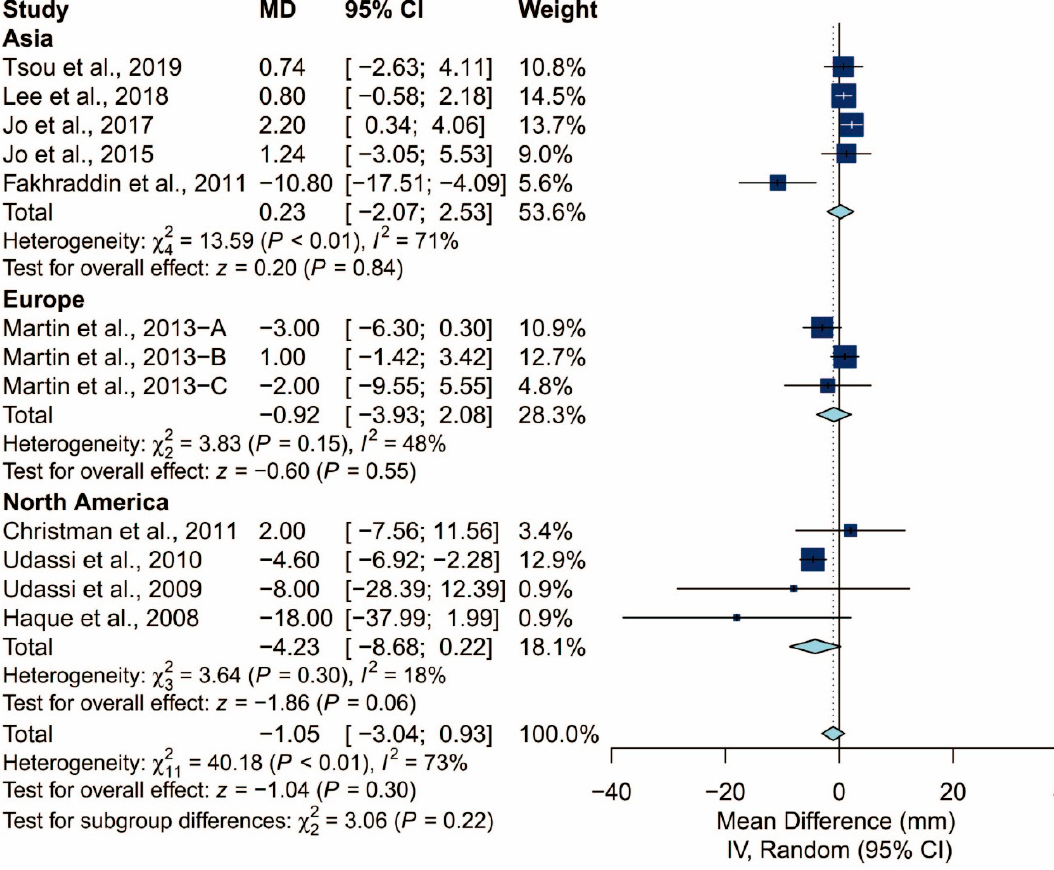
Figure 11. Subgroup analysis of chest compression rate grouped by manikin placement.